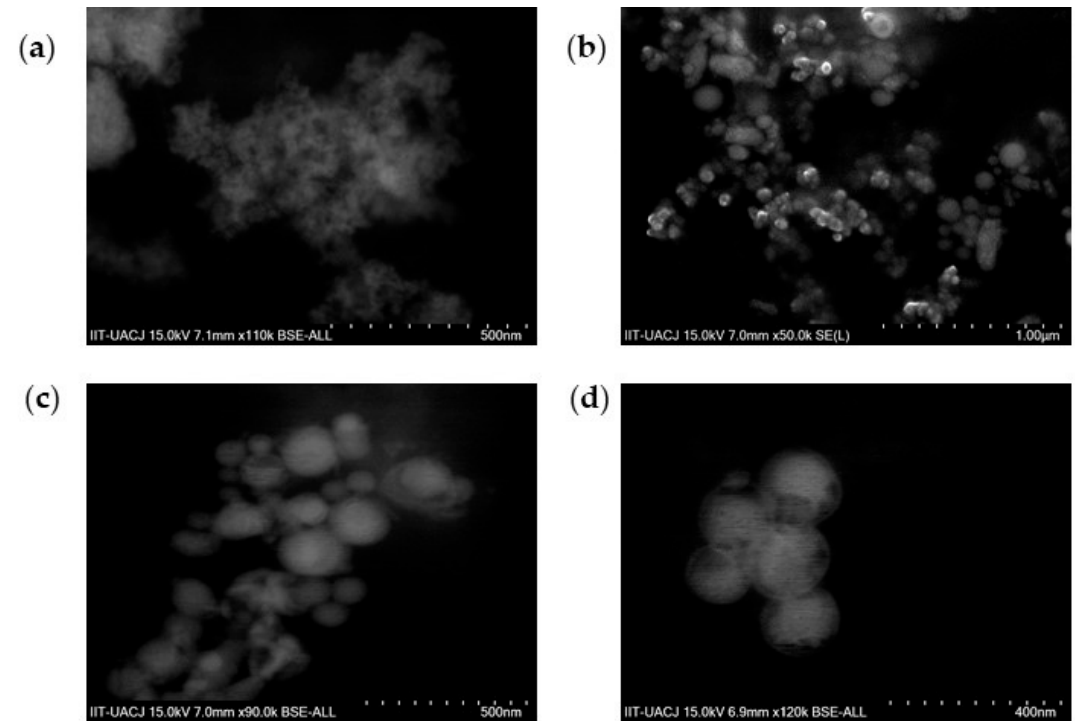
Figure 4. SEM images. ( a ) Magnetite nanoparticles and ( b – d ) magnetite nanoparticles coated with PEG 3350-Tween 80 at different magnifications. All the samples showed spherical shapes. In bare magnetite nanoparticles are evidence of agglomeration, while in magnetite nanoparticles coated with PEG 3350-Tween 80 the separation between one nanoparticle and other becomes more evident.